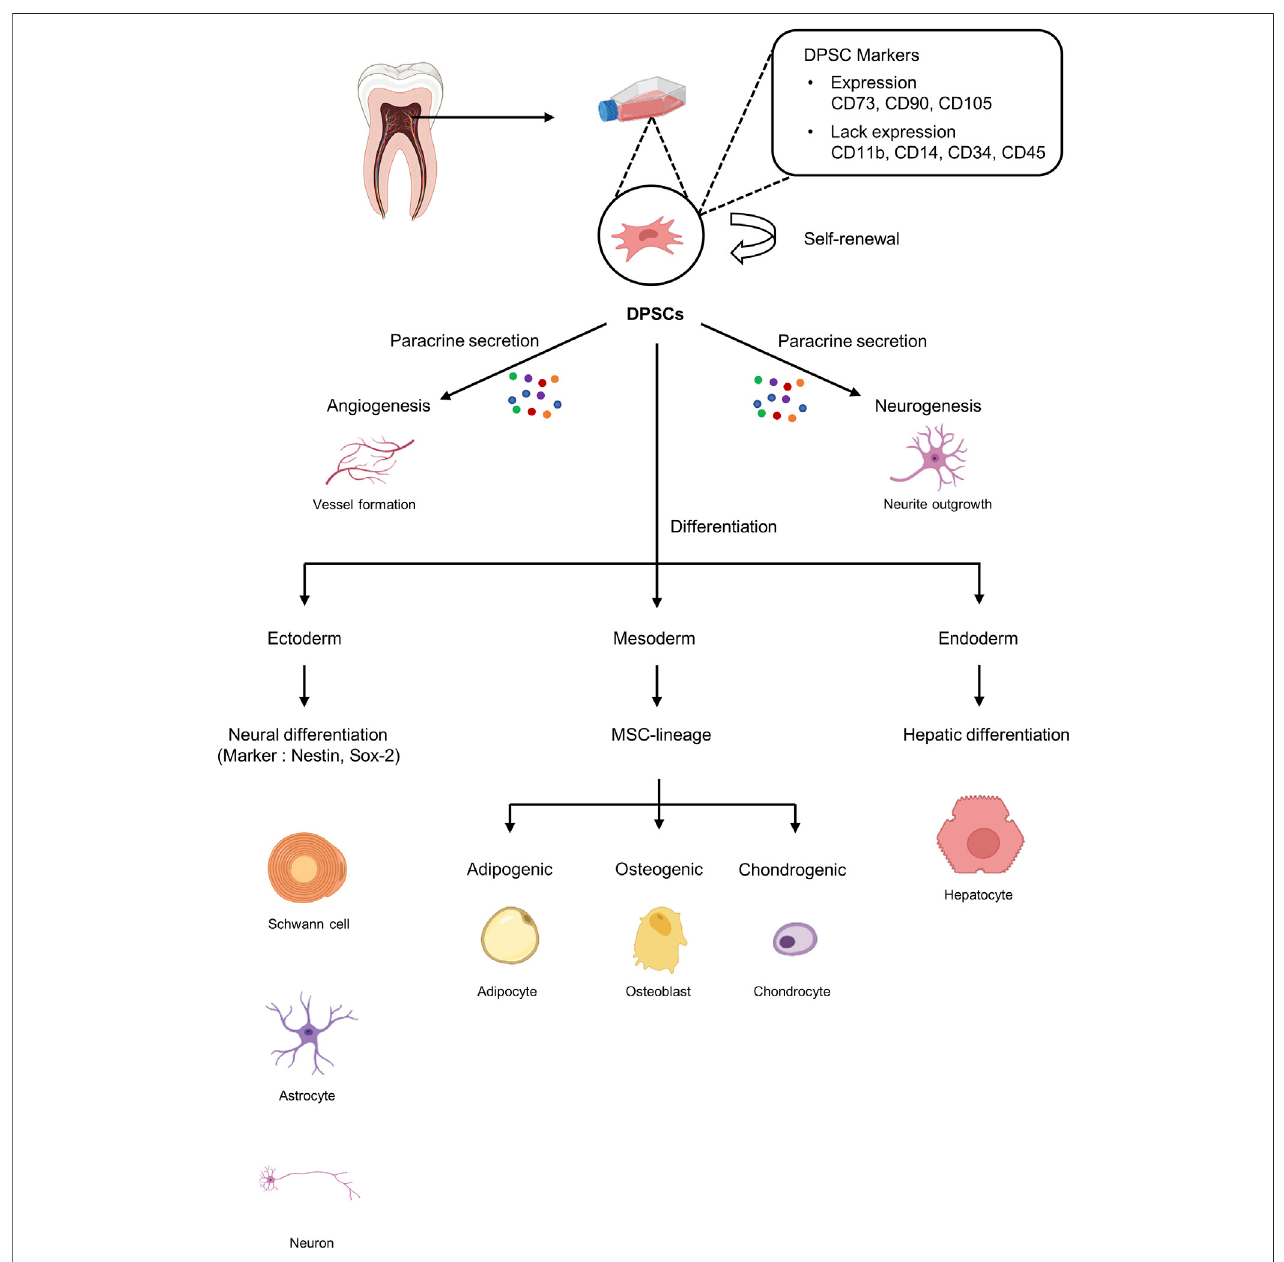
FIGURE 2 | Characteristics of dental pulp stem cells (DPSCs). DPSCs can be isolated from dental pulp tissue and express markers similar to those on mesenchymal stem cells (MSCs). DPSCs can undergo self-renewal and have the potential to differentiate into ectoderm, mesoderm, and endoderm.